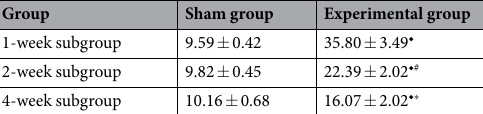
Table 3. Endothelial cell apoptosis index in the rat CTEPH model. Note: Data are expressed as (mean ± SD)%. ◆ P < 0.05, compared to the same week in the sham group; # P < 0.05, compared to the 1-week experimental subgroup; ∗ P < 0.05, compared to the 1- and 2-week experimental subgroups.